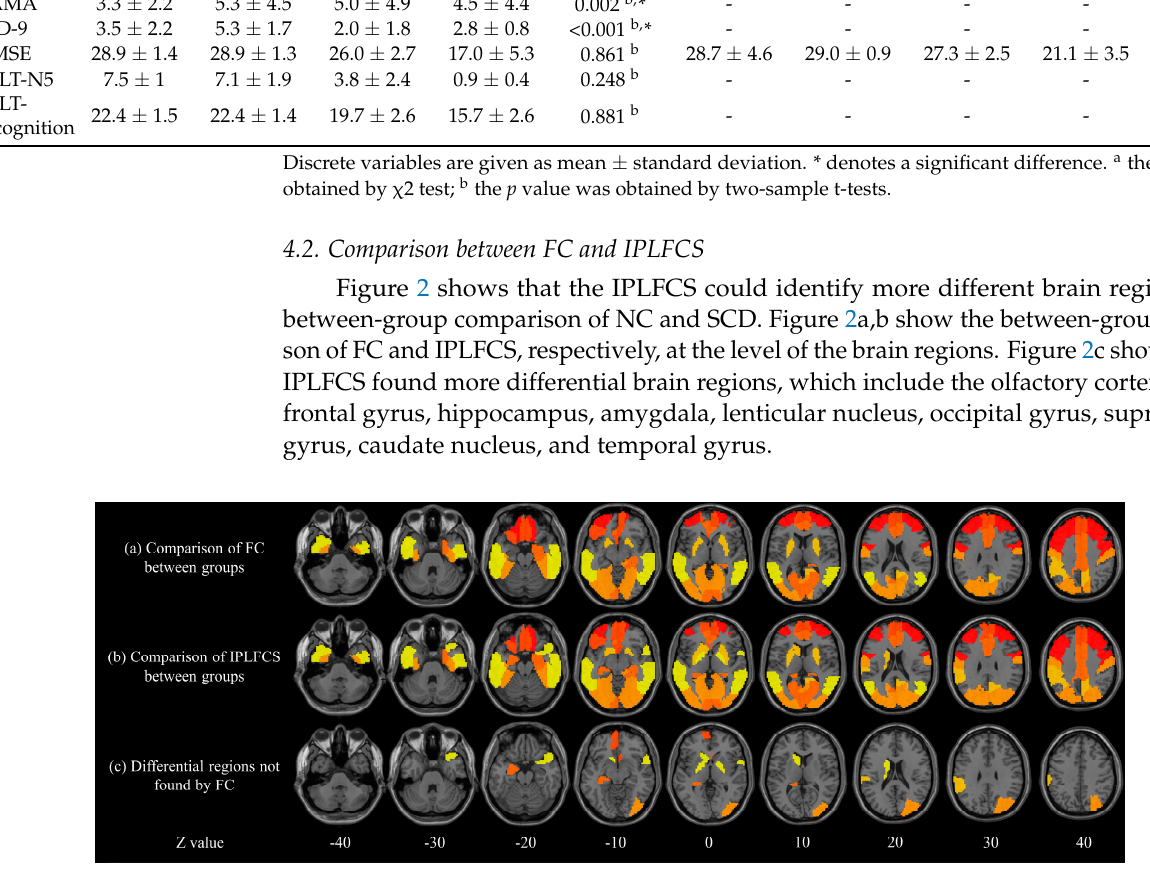
Figure 2. Group comparison between NC and SCD in brain regions. ( a ) Comparison of FC between group; ( b ) Comparison of IPLFCs between group; ( c ) Differential brain regions were found by the between-group comparison of IPLFCS but not in the between-group comparison of FC. Z value represents the z -axis of standard space. Differential brain regions found: amygdala and temporal gyrus (see Z = − 20), hippocampus and olfactory (see Z = − 10), superior frontal gyrus and lenticular nucleus (see Z = 0), caudate nucleus (see Z = 10), occipital gyrus (see Z = 20), and supramarginal gyrus (see Z =